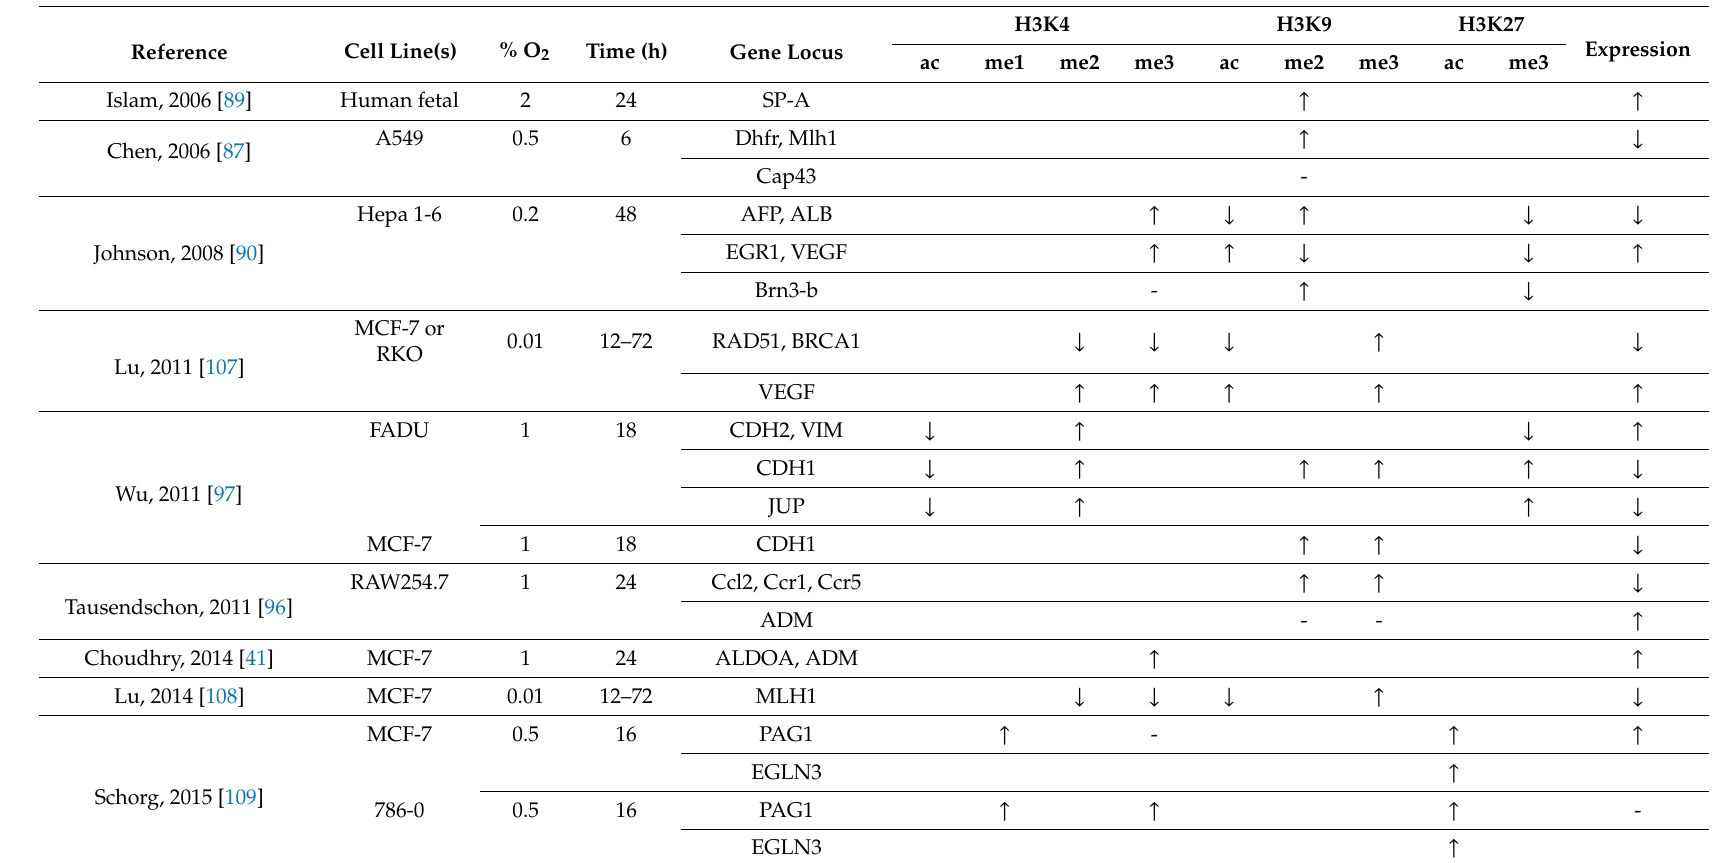
Table 4. Locus-specific changes in histone modifications in hypoxia. Publications showing locus-specific changes in histone methylation in hypoxia, as well as any associated change in expression of that gene, in a wide range of cell types, oxygen levels, and duration of hypoxia. Up arrows indicate induction specific PTMs, down arrows indicate global reduction, and dashes indicate no significant change. ac indicates acetylation at that specific histone subunit and lysine residue, while me1, me2, and me3 indicate mono-, di-, and tri- methylation,